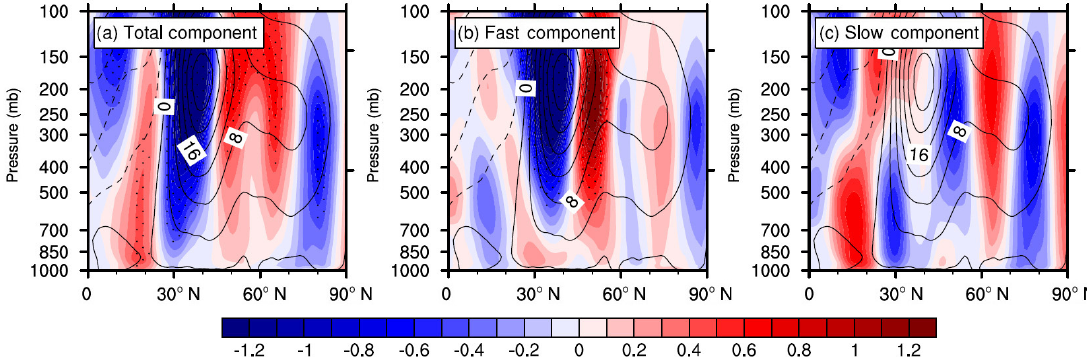
Figure 11. JJA mean total, fast, and slow responses of zonally averaged zonal wind between 100 and 140 ◦ E to BC forcing (unit: ms − 1 ) . The dashed and solid lines represent the climatological JJA mean easterly and westerly winds in PI, respectively. The dots represent significance at ≥ 95% confidence level from the t test.